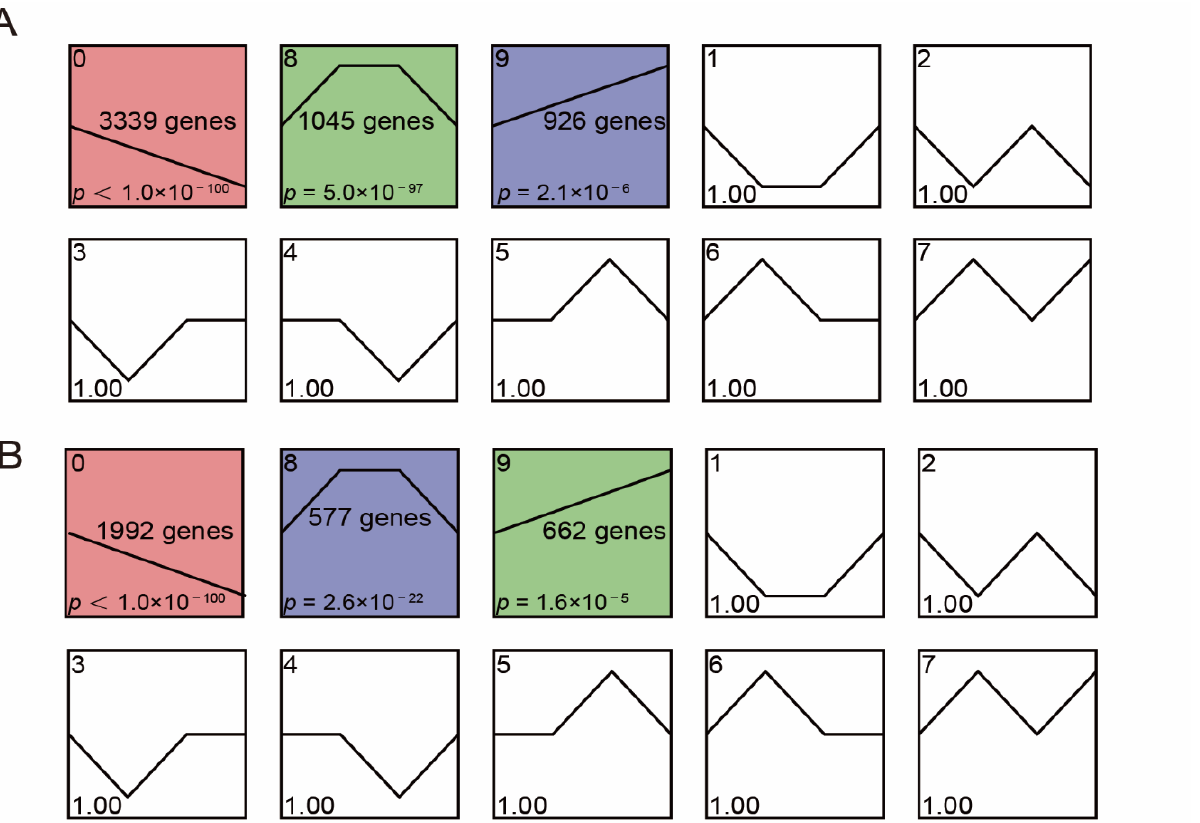
Figure 4. Time-course gene expression and functional enrichment analysis. ( A , B ) Time – series mod- ules of DE-mRNAs ( A ) and DE-lncRNAs ( B ) are shown. The significantly enriched profiles are red, purple, and green colored ( p < 0.05). The numbers in the upper-left corner of each pane denote the profile number; the numbers in the middle of each pane denote the number of genes in each profile; the numbers in the lower-left corner of each pane denotes the p -value of each profile. ( C ) Functional enrichment analysis of DE-mRNAs corresponding to significant profiles.